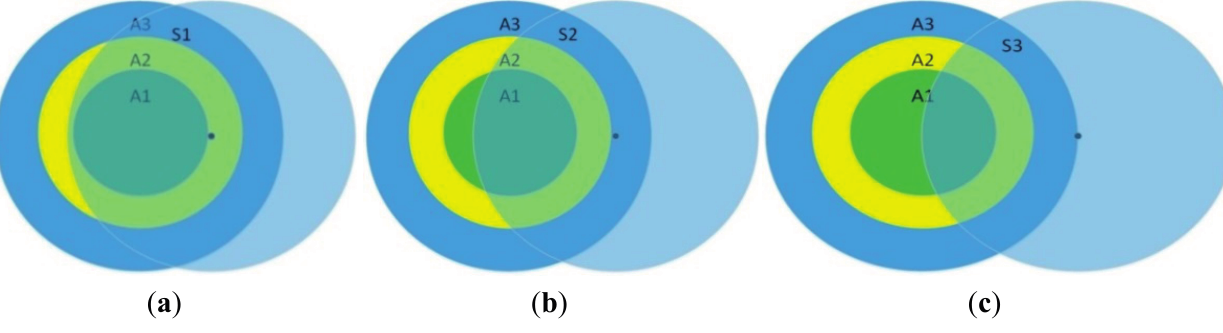
Figure 8. An example of how nodes are deployed at the boundary of area ( a ) A1; ( b ) A2 and ( C )